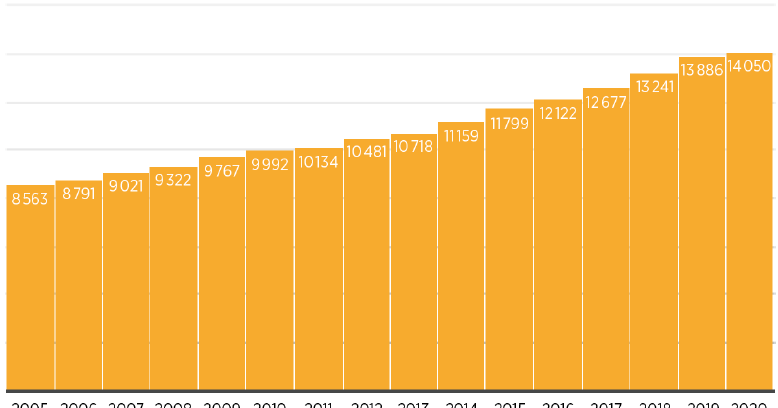
Figure 1. Global geothermal energy capacity from 2005 to 2020 (MWe). Source: Reprinted from [32].